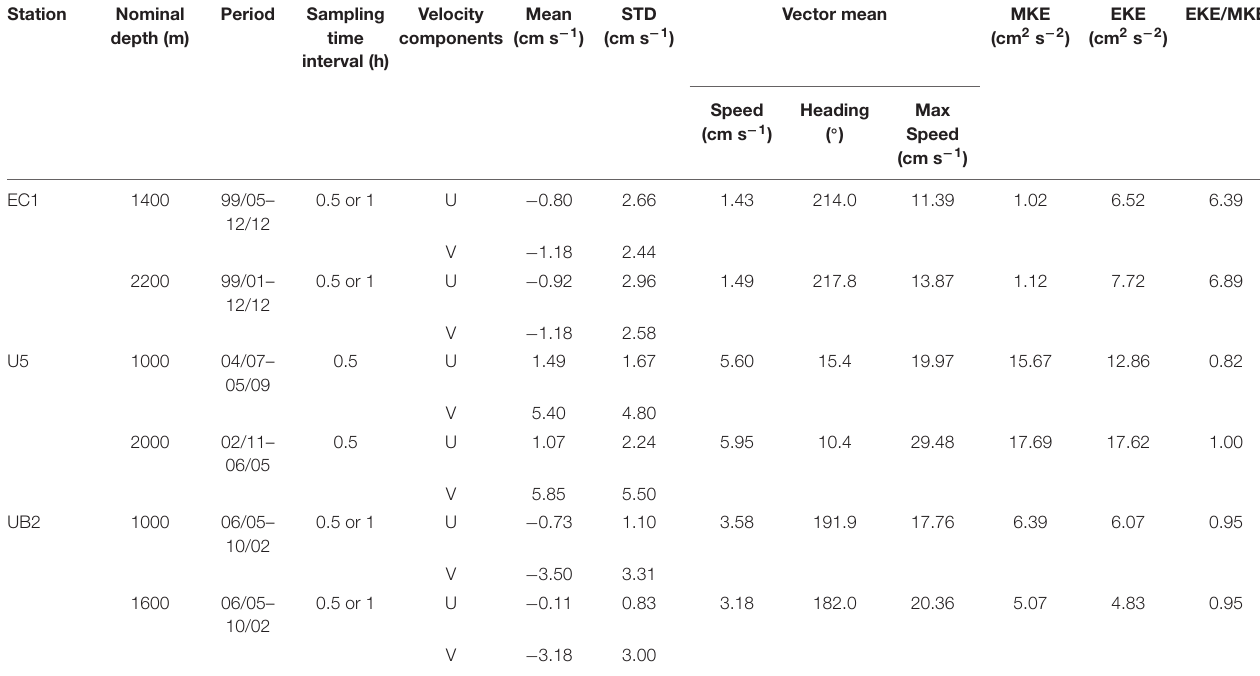
same filters used to extract fluctuations at the two intraseasonal bands. Considering the bottom topography in the vicinity of U5, bandpass-filtered currents were decomposed into along-slope ( U r , 10 ◦ rotated clockwise from the north) and cross-slope ( V r ) components. The bathymetry data used in the HYCOM dataset (GLBu0.08_07b) were used to estimate the along-isobath angle at scales of several tens to a few hundreds of kilometers ( Figure 2B